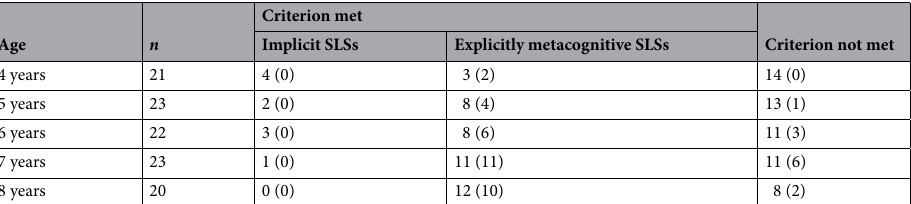
Table 2. Categorising switch phase performance as explicitly metacognitive or implicit SLSs. Children who selected the knowledgeable informant in at least four switch trials were categorised as having employed an explicitly metacognitive SLS. Children who did not meet criterion were not categorised as having employed either SLS. Numbers in parentheses indicate the number of children who provided a reasoned correct response to the explicit verbal reasoning question.